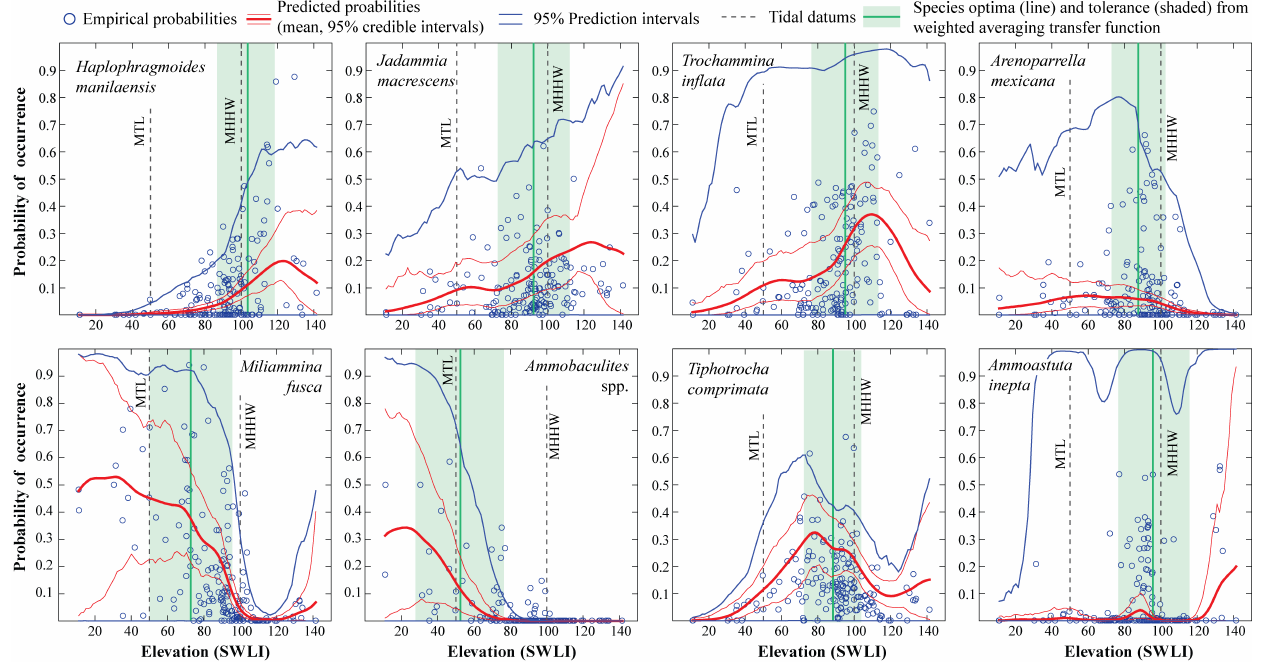
Figure 4. The response of foraminifera species to elevation estimated from the modern training set of raw counts using the Bayesian transfer function. The blue circles represent the probabilities of species occurrence as determined from the count data (empirical probabilities). The response probabilities of occurrence estimated by the Bayesian transfer function model are shown with a mean (heavy red line), a credible interval for the mean (light red line), and a prediction interval (blue line). The green vertical lines and shading represent the species optima and tolerances determined from the weighted average transfer function. Tidal datums are indicated by vertical dashed black lines. MTL is mean tide level and MHHW the mean higher high water. SWLI indicates the standardized water level